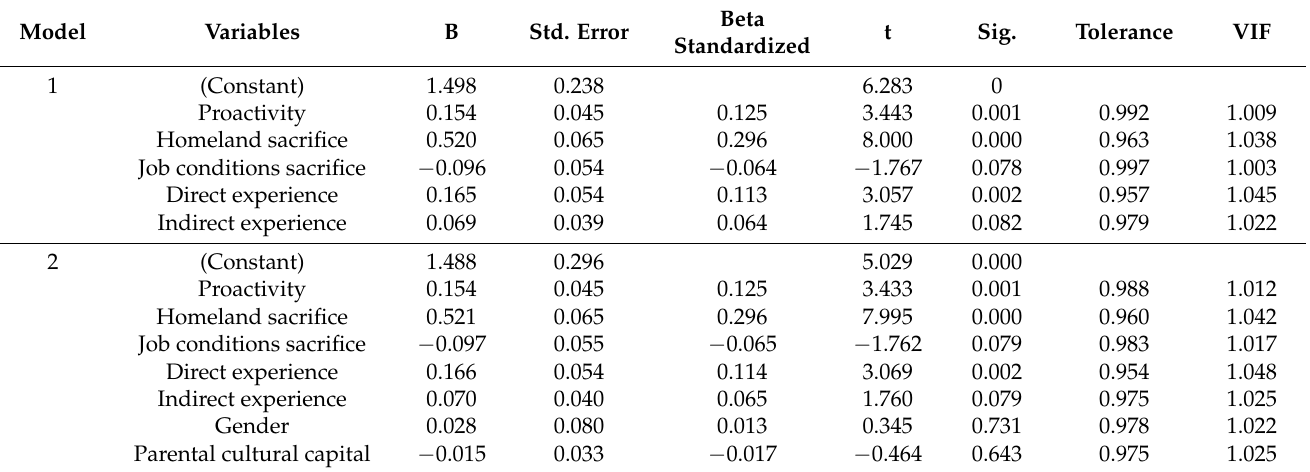
Table 3. Multiple regression model ( n =